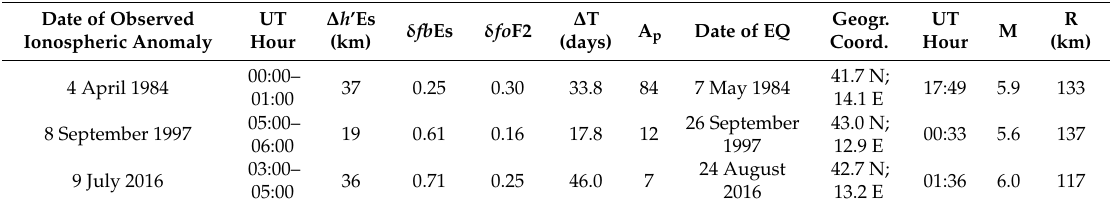
Table 3. Revealed ionospheric anomalies during disturbed magnetic conditions and corresponding EQs. Daily A p indices are given as well.